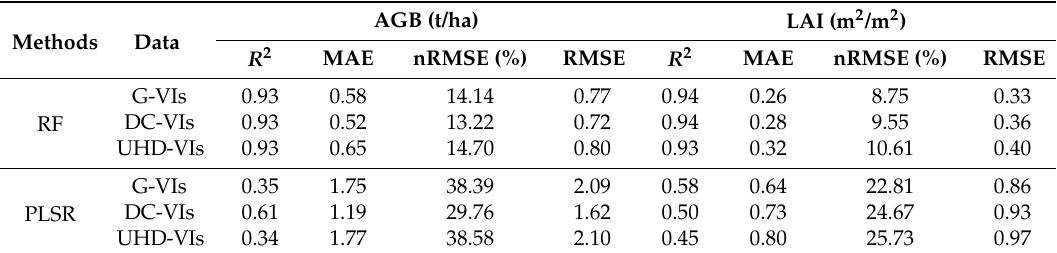
Table 7. Leaf area index and above-ground biomass estimates based on all vegetation indices from calibration dataset and using partial least square regression and random forest methods